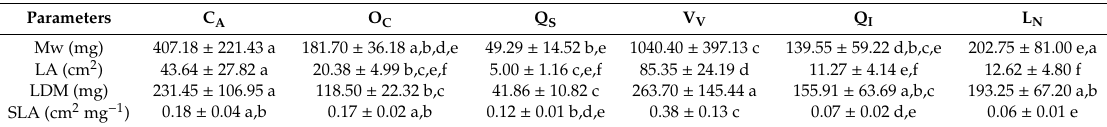
Table 1. Leaf water mass (M w ), leaf area (L A ), leaf dry mass (LDM), and specific leaf area (SLA) of each species investigated (average ± SD). Data that do not share superscript letters di ff er significantly (Tukey’s multiple test) at p ≤ 0.05.